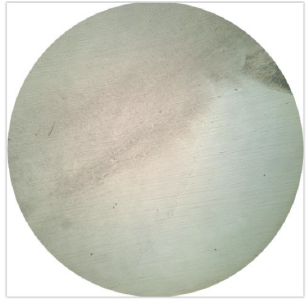
Figure 5. Example of a very monotonous fragment of a slide (part of the root)